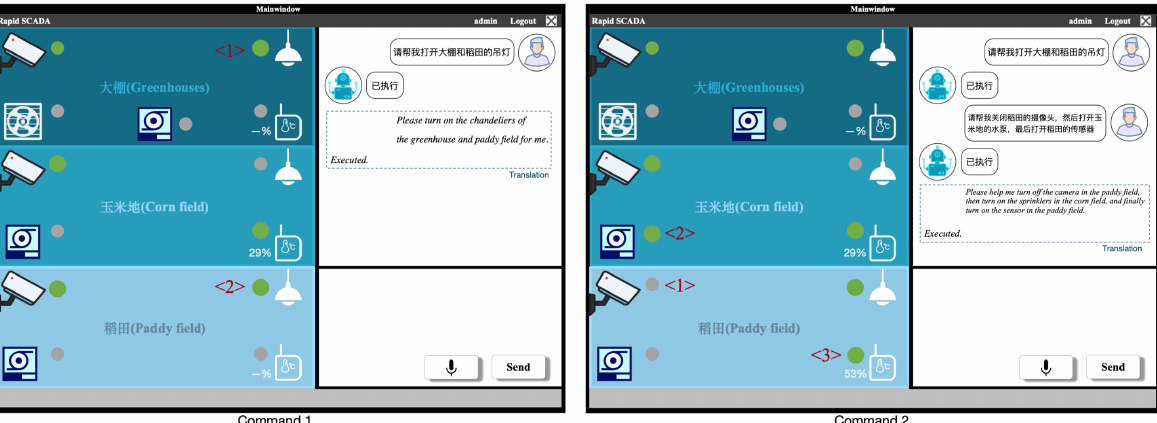
Figure 13. Desktop platform human–machine interaction interface in